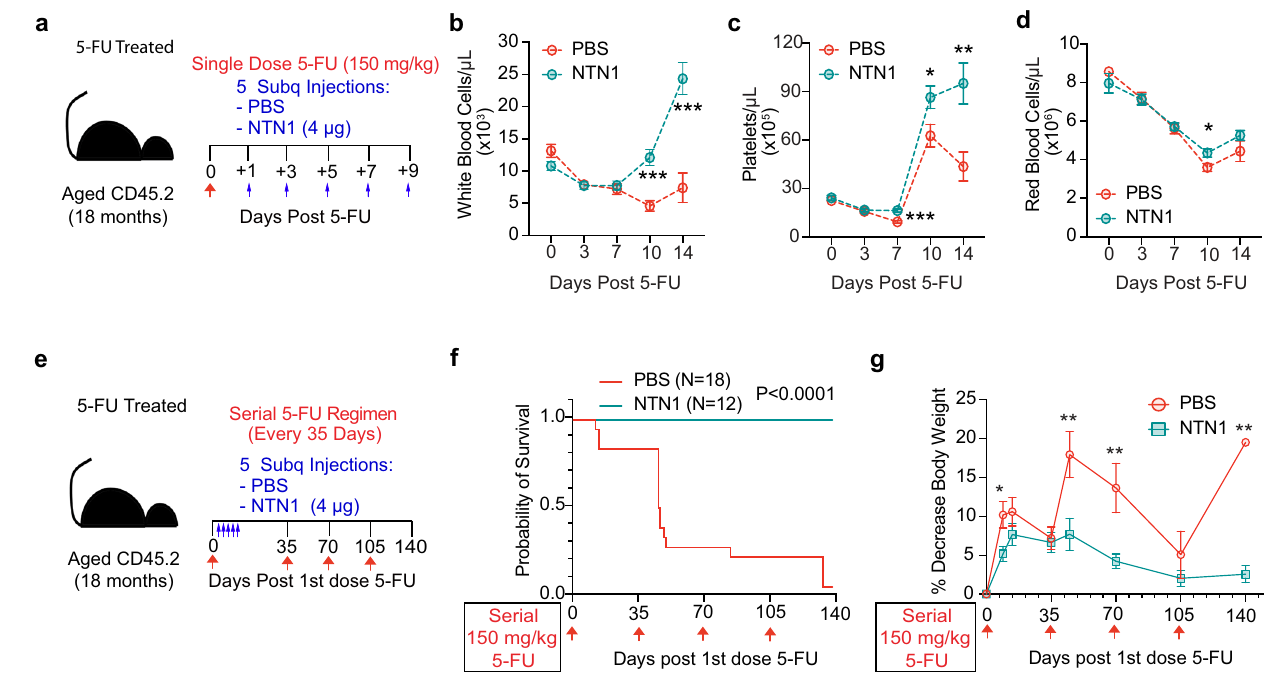
Fig. 9 | NTN1 restores the regenerative capacity of aged HSCs. a Experimental design for NTN1 treatment following a single dose of 5-FU. b – d Complete blood counts quantifying WBCs b , Platelets c , and RBCs d (PBS N =19 (Days 0 & 3), N =17 (Days 7 &10), N =6 (Day 14), NTN1 N =20(Days 0,3 & 7), N =18(Day 10), N =7 (Day 14)). e Experimental design for NTN1 treatment following serial 5-FU treatment. f Kaplan-Meier survival curve (PBS N =18, NTN1 N =12). Statistical signi fi cance determined using Log-rank (Mantel-Cox) test. g Analysis of total body weight